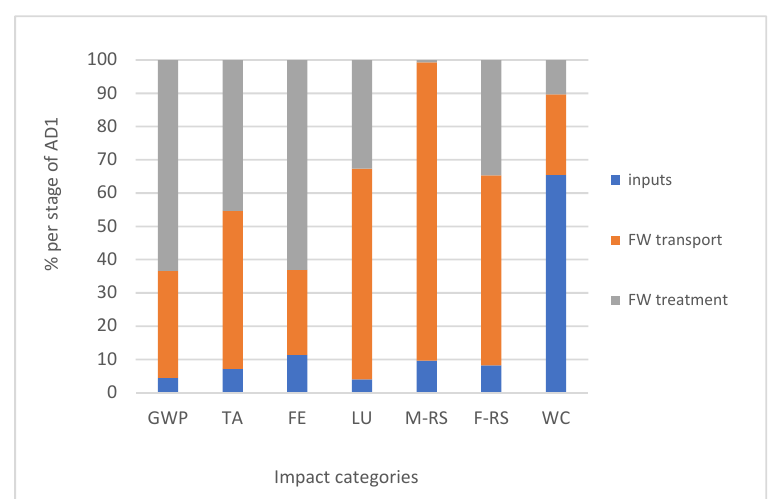
Figure 5. Impacts from FW landfilling disposal (LF).